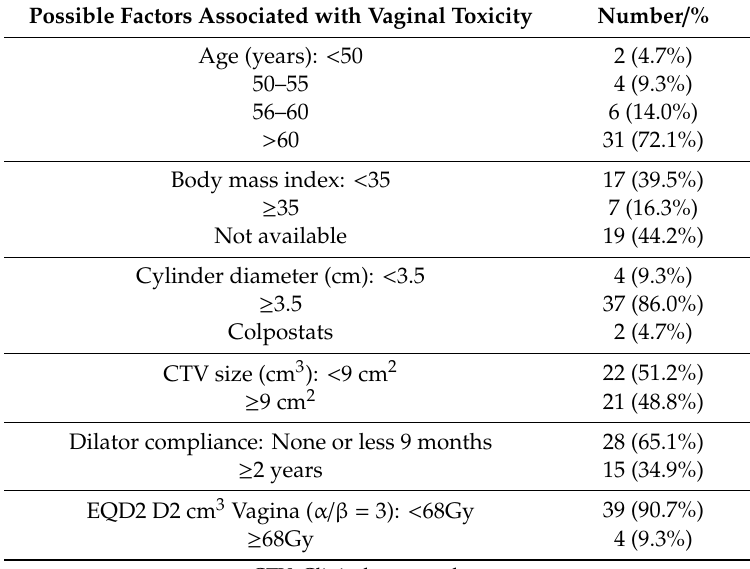
Table 1. Shows the distribution of the possible factors related to vaginal toxicity in the present series. Possible Factors Associated with Vaginal